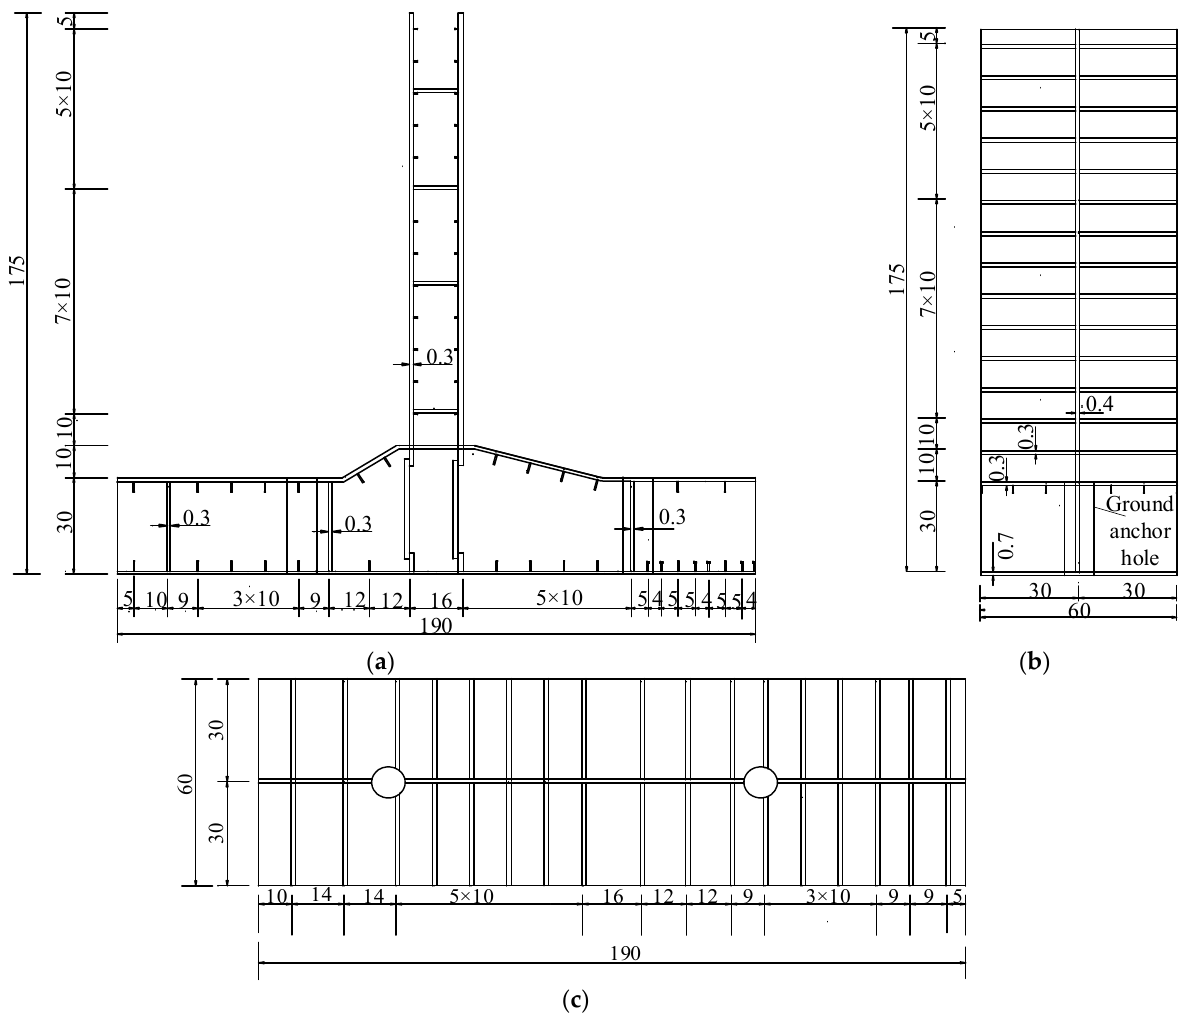
Figure 3. Design details of the T-shaped specimen (unit: cm). ( a ) Front view; ( b ) side view; ( c ) top